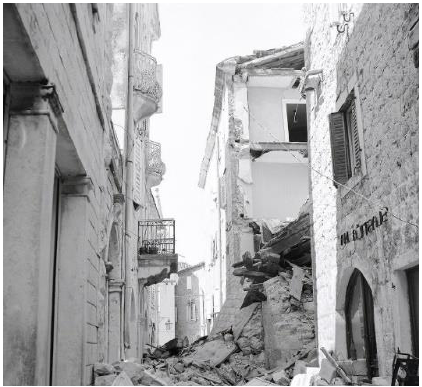
Figure 1. Colapse of row houses in urban environment (Kotor).